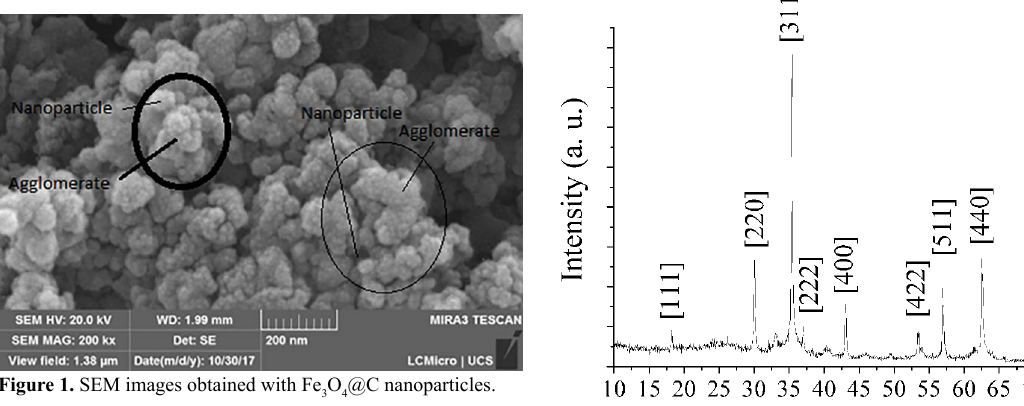
Figure 1. SEM images obtained with Fe